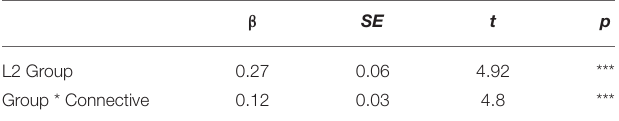
TABLE 4 | Model of both L1 + L2 data (Experiment 1).